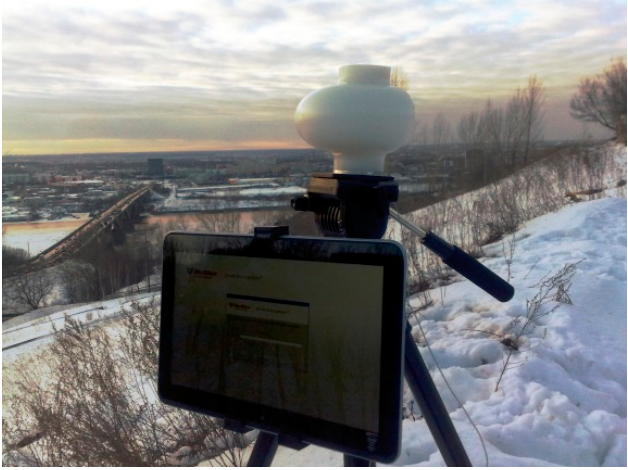
Figure 8. Constellation diagrams for the backhaul link with an LAA at the TX and RX side. Sensors 2016 , 16 , 1362